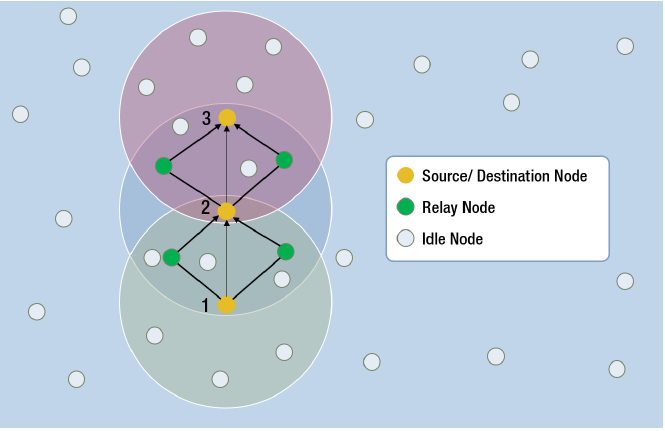
Figure 5. Data transmission in Cooperative Depth Based Routing (CoDBR)